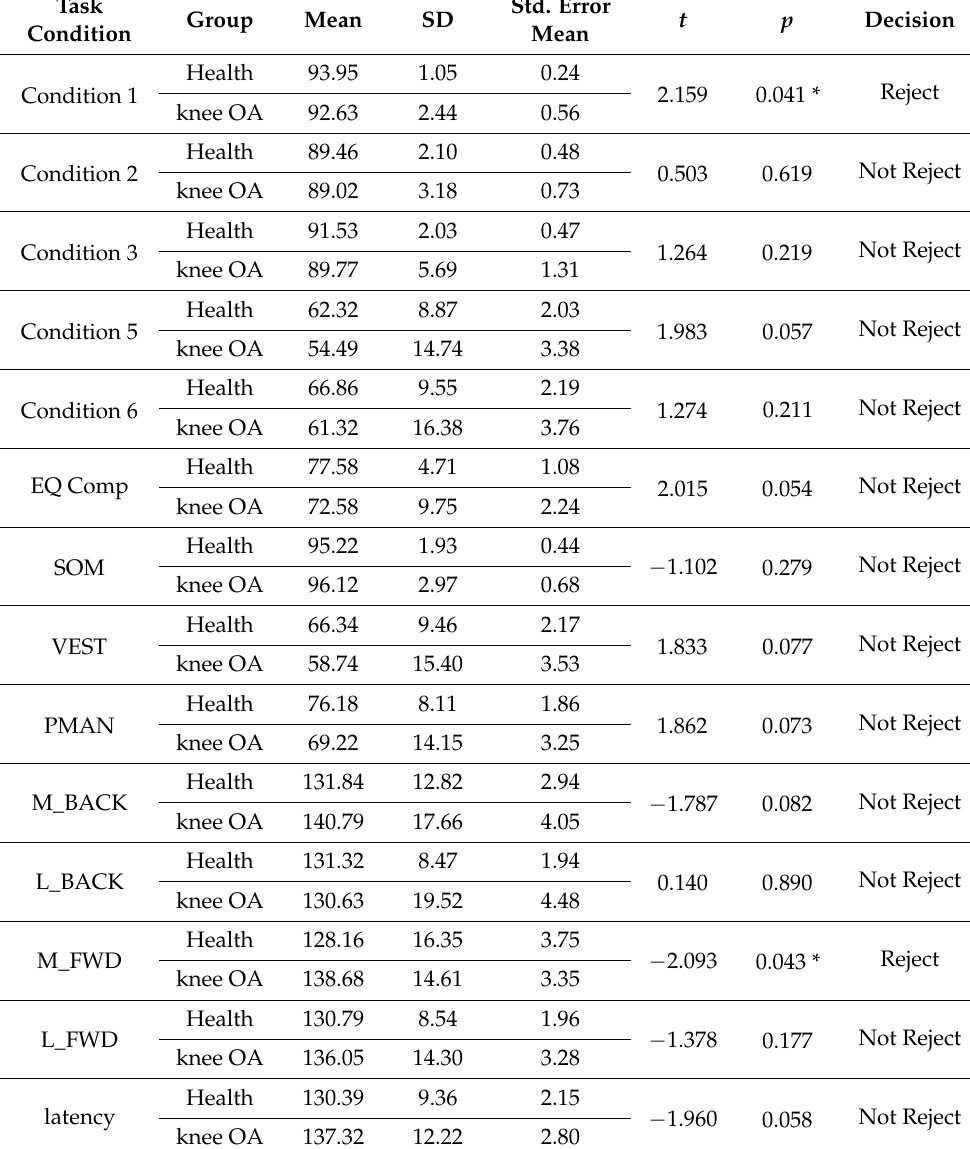
Table A2. Comparison between knee OA group and health knee group with textured insoles. (Null hypothesis: both knee OA and healthy knee group with textured insoles will have the same scores from balance tests.)